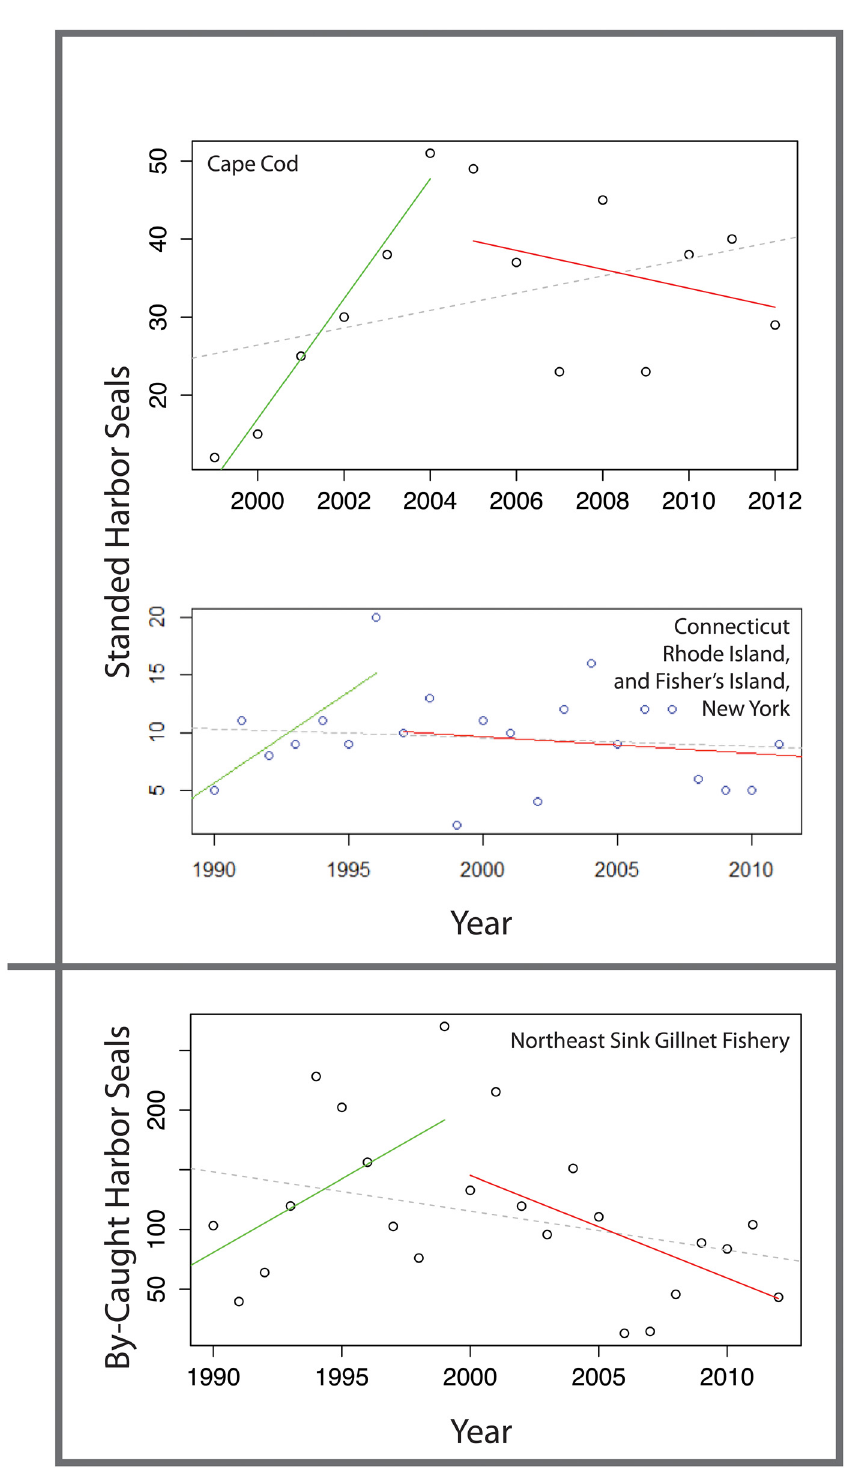
Fig 2. Strandings of harbor seals in the Cape Cod and Connecticut, Rhode Island, and Fisher ’ s Island, New York regions, and bycatch for the Northeast Sink Gillnet Fishery. Yearly values indicated by open circles, pre-breakpoint linear model fits indicated by green lines, post breakpoint linear model fits indicated by red lines. Overall regression indicated by dashed gray lines.